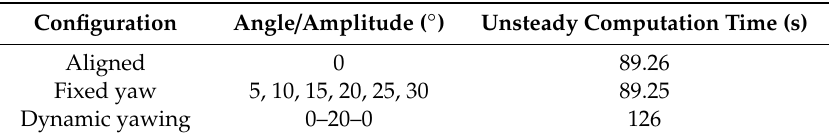
Figure 6. Variation of yaw velocity under different transient start-stop processes.